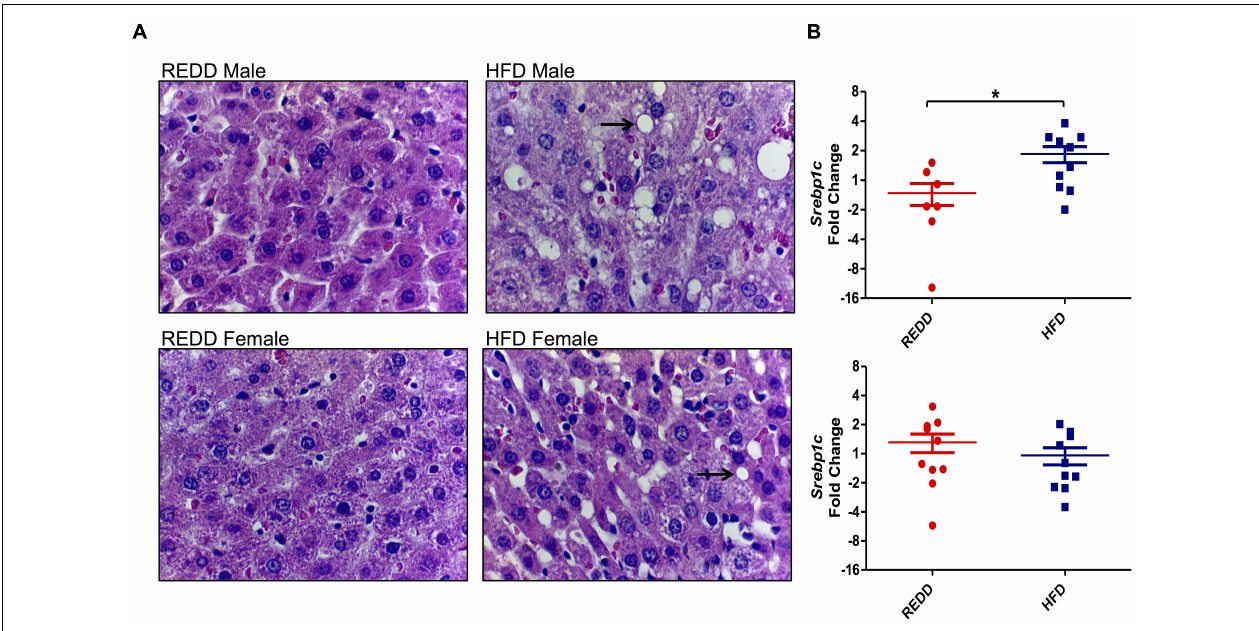
FIGURE 3 | HFD induces morphological changes in the liver. (A) Representative liver histology sections at 400 × magnification of REDD-fed male (top left), HFD-fed male (top right), REDD-fed female (bottom left), and HFD-fed female (bottom right) rats. Arrows identify fat deposits. (B) Hepatic Srebp1c gene expression quantified by qRT-PCR between male (top) and female (bottom). Rplp0 expression was used as an internal standard. Results are expressed as Log 2 (Fold Induction) with repression values (i.e., < 1) expressed as its negative reciprocal (i.e., 0.5 = − 2). Numerical data are summarized as means ± SEM. ∗ p < 0.05. REDD = reduced energy density diet; HFD = high fat